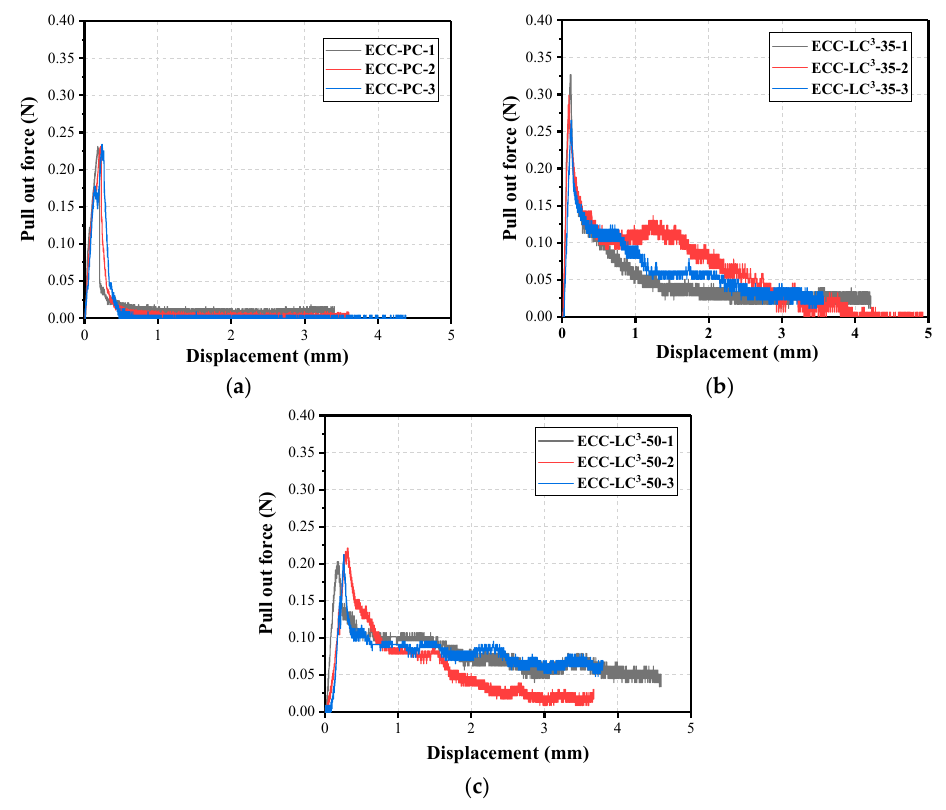
Figure 14. Single fiber pullout curves: ( a ) ECC-PC; ( b ) ECC- LC 3 –35; ( c ) ECC- LC 3 –50.